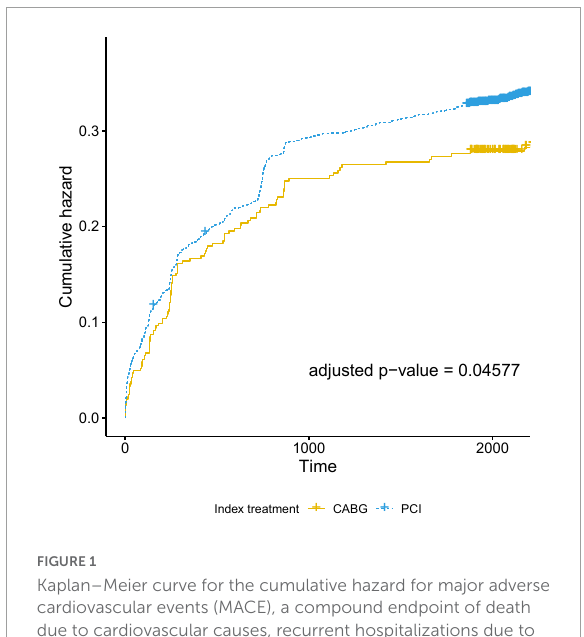
FIGURE1 Kaplan–Meier curve for the cumulative hazard for major adverse cardiovascular events (MACE), a compound endpoint of death due to cardiovascular causes, recurrent hospitalizations due to cardiovascular ischemic events and incident heart failure New York Heart Association III-IV.